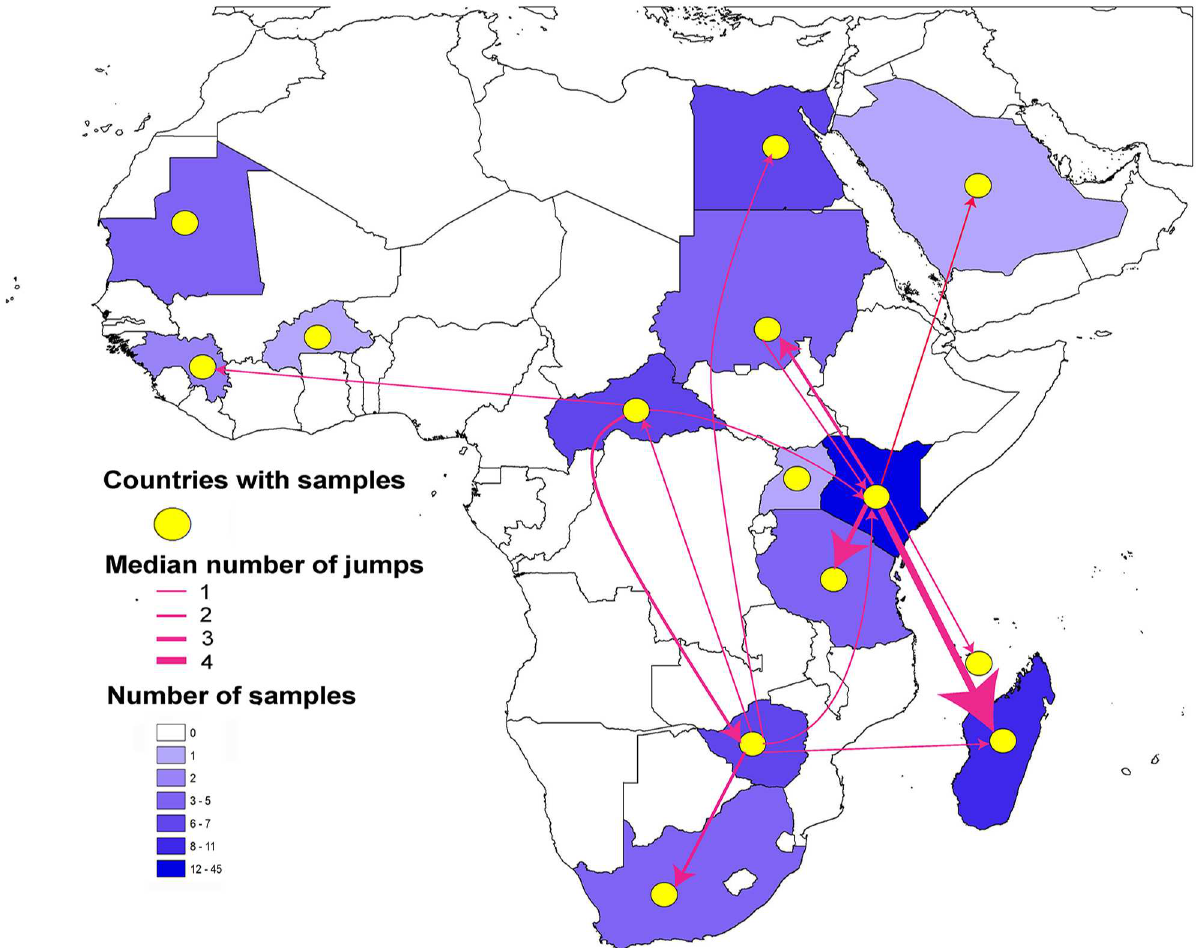
Fig 4. Connectedness of countries with Rift Valley Fever outbreaks based on Markov Jumps reconstruction using the medium minigenomic segment (M) of RVFV isolates in the study. Connectionsbetween countries are presented as lines with arrows to refer to the direction of movement. Line thickness identifies the mediannumber of jumps betweeneach country